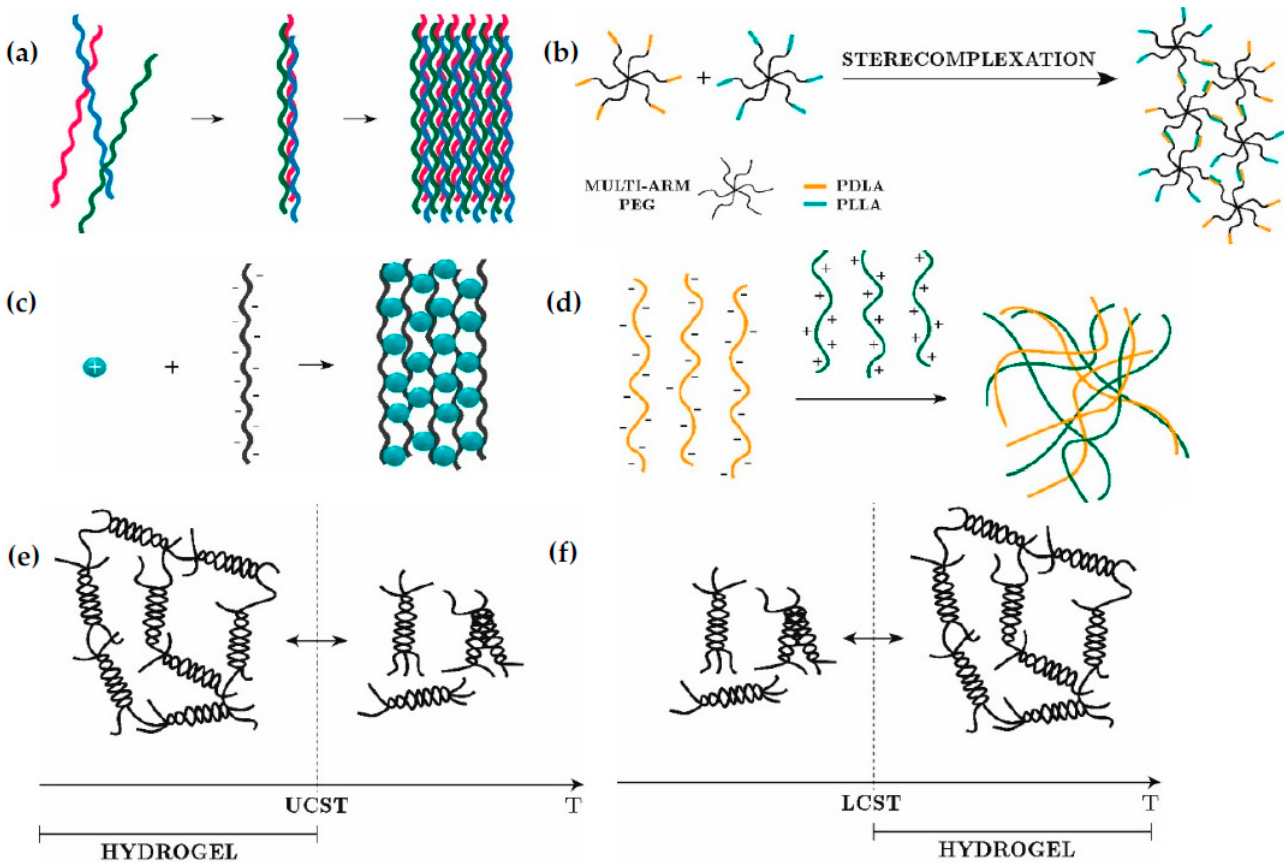
Figure 1. Physical cross-linking. ( a ) Self-assembly. ( b ) Stereo-complexation. ( c ) Ionic-chelation. ( d ) Ionic–electrostatic interaction. ( e ) Thermal condensation UCST. ( f ) Thermal condensation LCST.